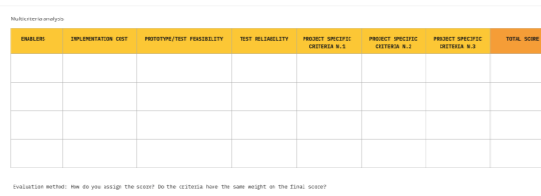
Fig. 6. Tech prioritization